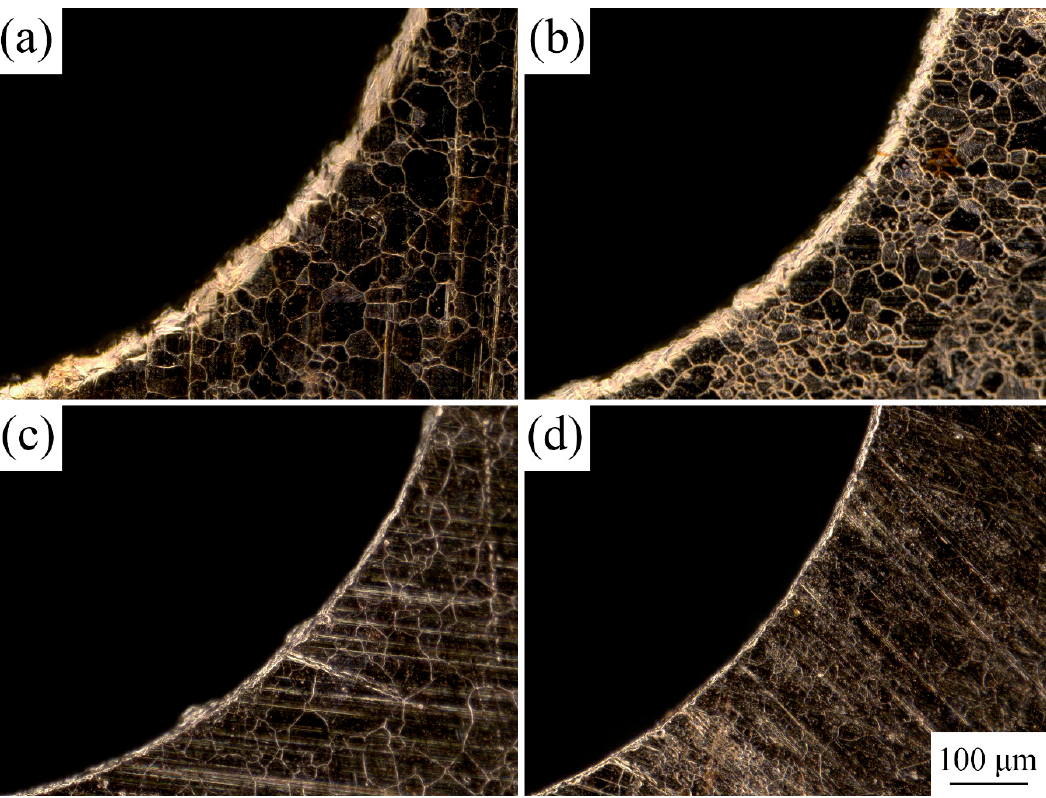
Figure 20. Influence of initial grain size on the shape accuracy of punched holes with and without LPS under a laser energy density of 38.2 J/cm 2